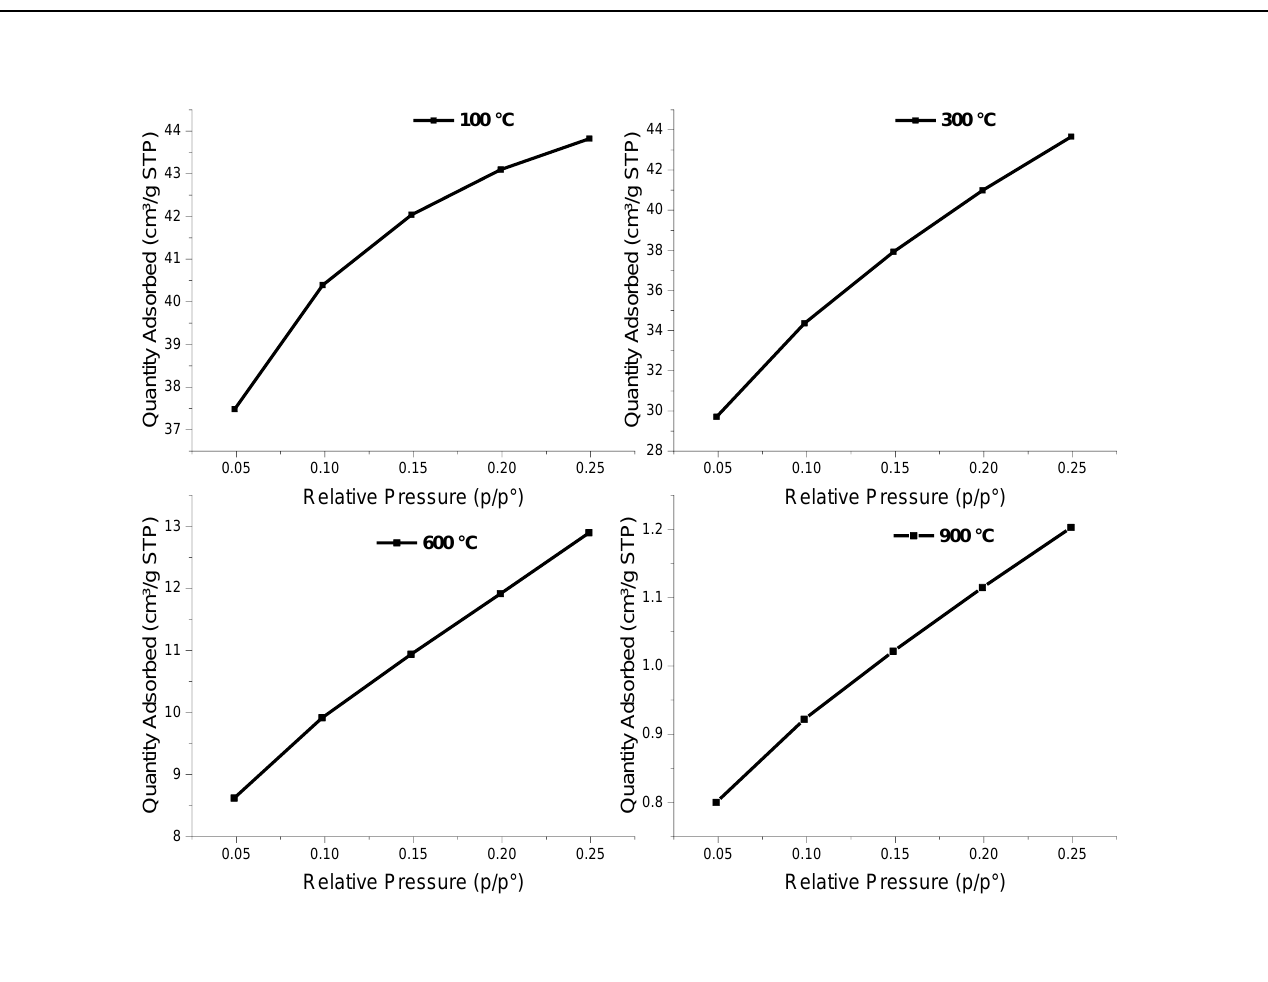
Figure 2. Linear N2 adsorption plots of SnO 2 NPs calcined at different temperatures. Table 1. Surface area, pore size, and volume of SnO 2